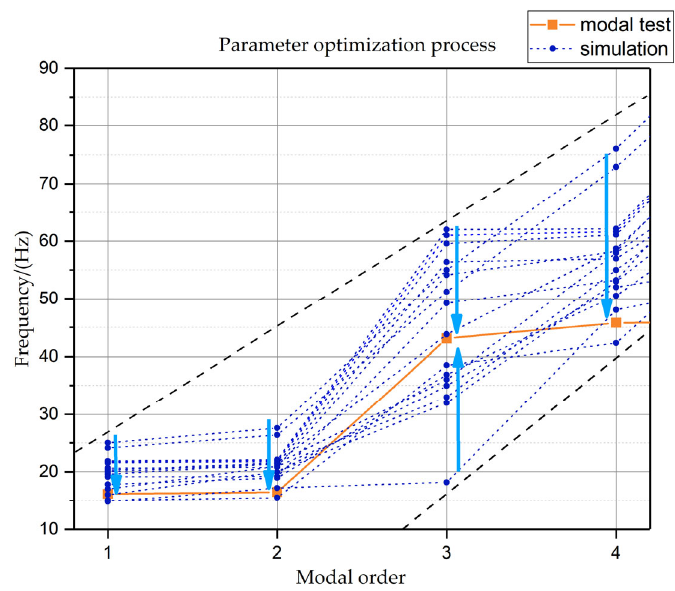
Figure 11. Schematic diagram of parameter optimization calculation process.